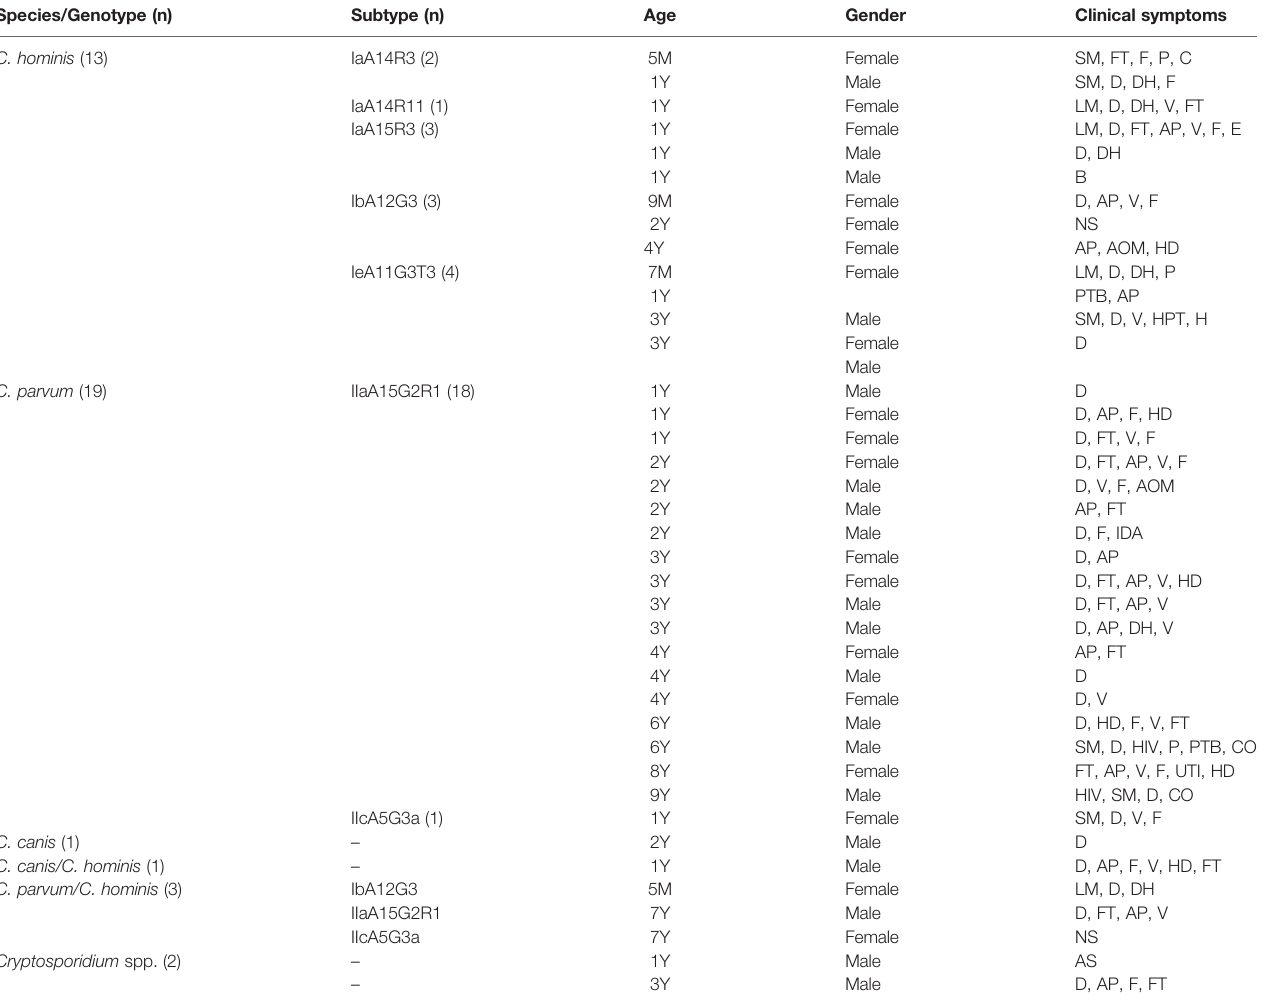
TABLE 1 | Cryptosporidium species and subtypes identi fi ed from Sonora, Mexico. Species/Genotype